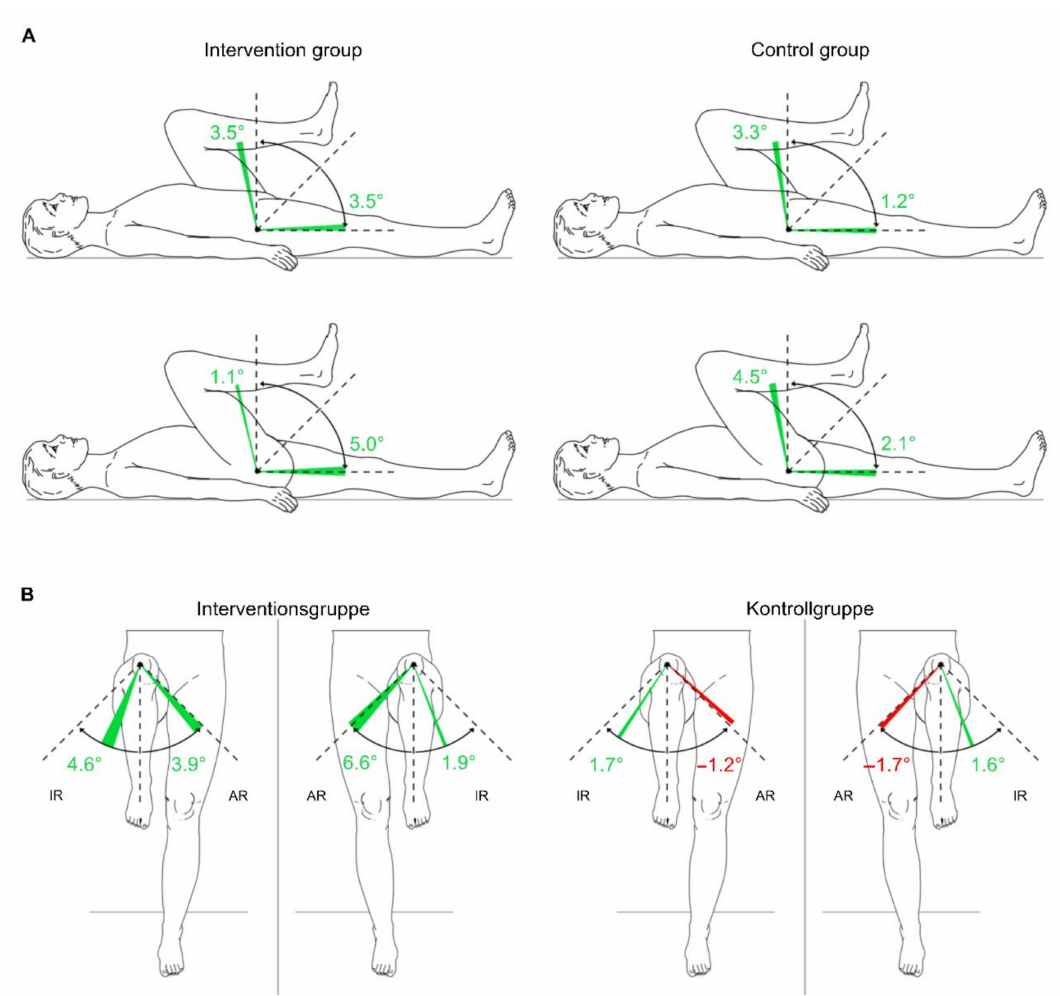
Figure 7. Changes in the passive range of motion of the hip joint in the intervention group and control group from T1 to T2 on average. ( A ): hip joint on sagittal plane; ( B ): hip joint on frontal plane. Green area: positive delta results from T1 to T2; red area: negative delta results from T1 to T2; IR: internal rotation; ER: external rotation; T1: measurement pre-intervention; T2: measurement post-intervention; n = 25. Source: authors’